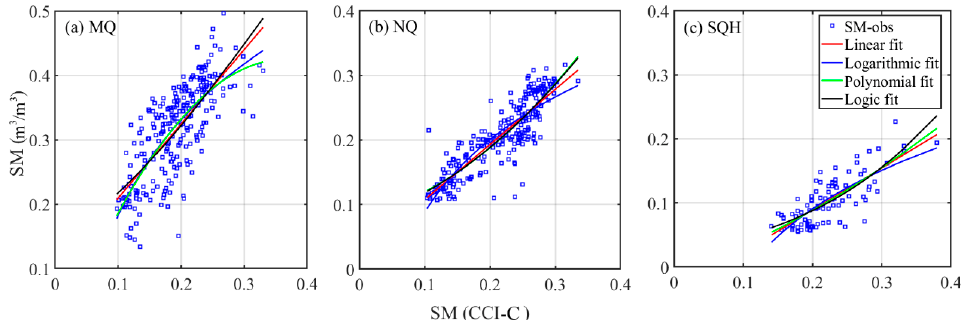
Figure 4. Scatter plots and fitting curves of the in-situ observed and CCI-C SM data (m 3 /m 3 ) in the MQ, NQ, and SQH areas during June to September in 2014 and 2015. Four fitting methods were used to fit the data.